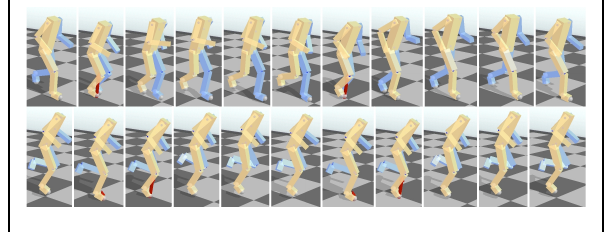
Figure 5. Animation of virtual characters using